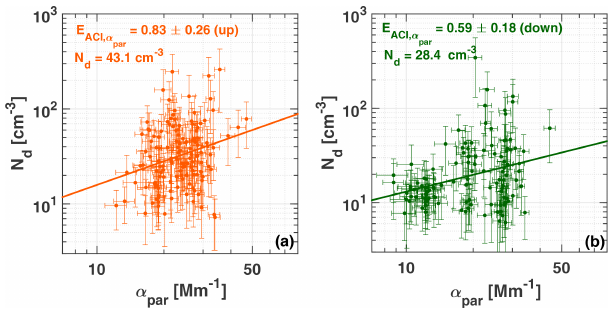
Figure 11. Cloud droplet number concentration N d (for height z ref = 75m above the cloud base) vs. aerosol particle extinction co- efficient α par , separately for (a) updraft and (b) downdraft periods. The N d and α par values shown in Fig. 9 are used (375–600m below the cloud base). In total, almost 260 values were available for the regression analysis. Error bars show the uncertainties in the N d and α par values. The linear regression fits a straight line to the log N d – = 0 . 87 ± 0.26 (orange log α par data field with the slope E ACI ,α par slope) and 0.58 ± 0.17 (green slope). The mean droplet number con- centration (given as numbers) was about 50% higher during the up- draft periods than during the downdraft